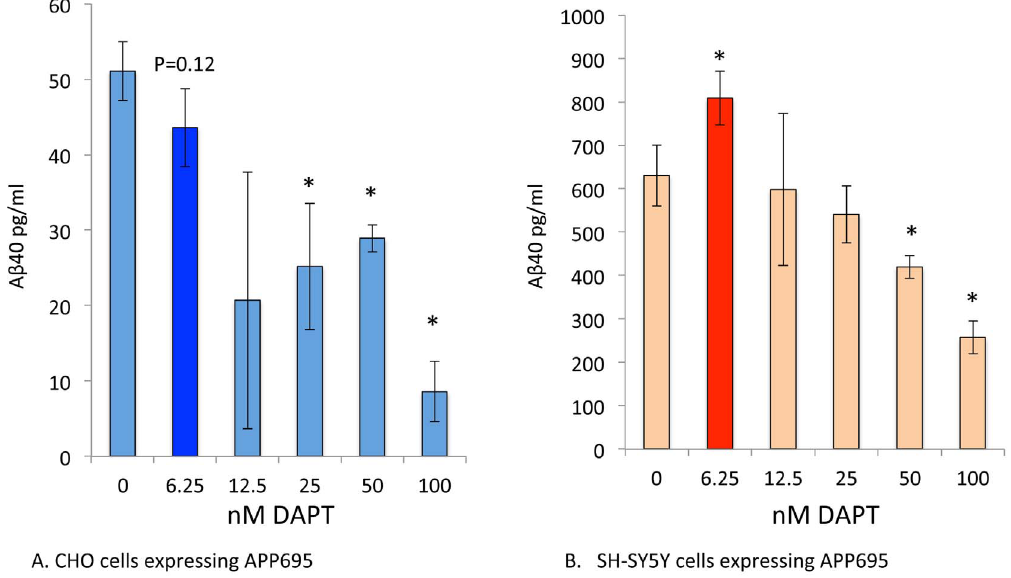
Figure 6. CHO cells fail to display the DAPT induced stimulation of A b . CHO cells and SH-SY5Y cells expressing human APP695 were treated with 6.25, 12.5, 25, 50 and 100 nM DAPT for 2 h. DAPT induced the consistent increase in A b 40 at 6.25 nM ( , 0.05), but the CHO-APP695 failed to show any stimulation of A b 40 but showed a trend towards reduction (P=0.12) instead. A b 42 was not detectable in these transfected CHO- APP695 cells.